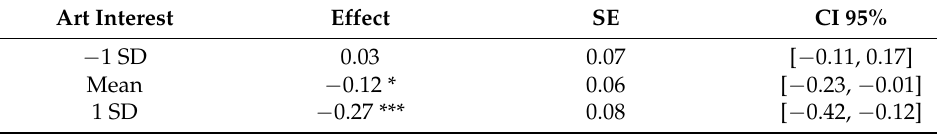
Figure 1. Simple slope analysis. Table 3. Conditional effect of the focal predictor.